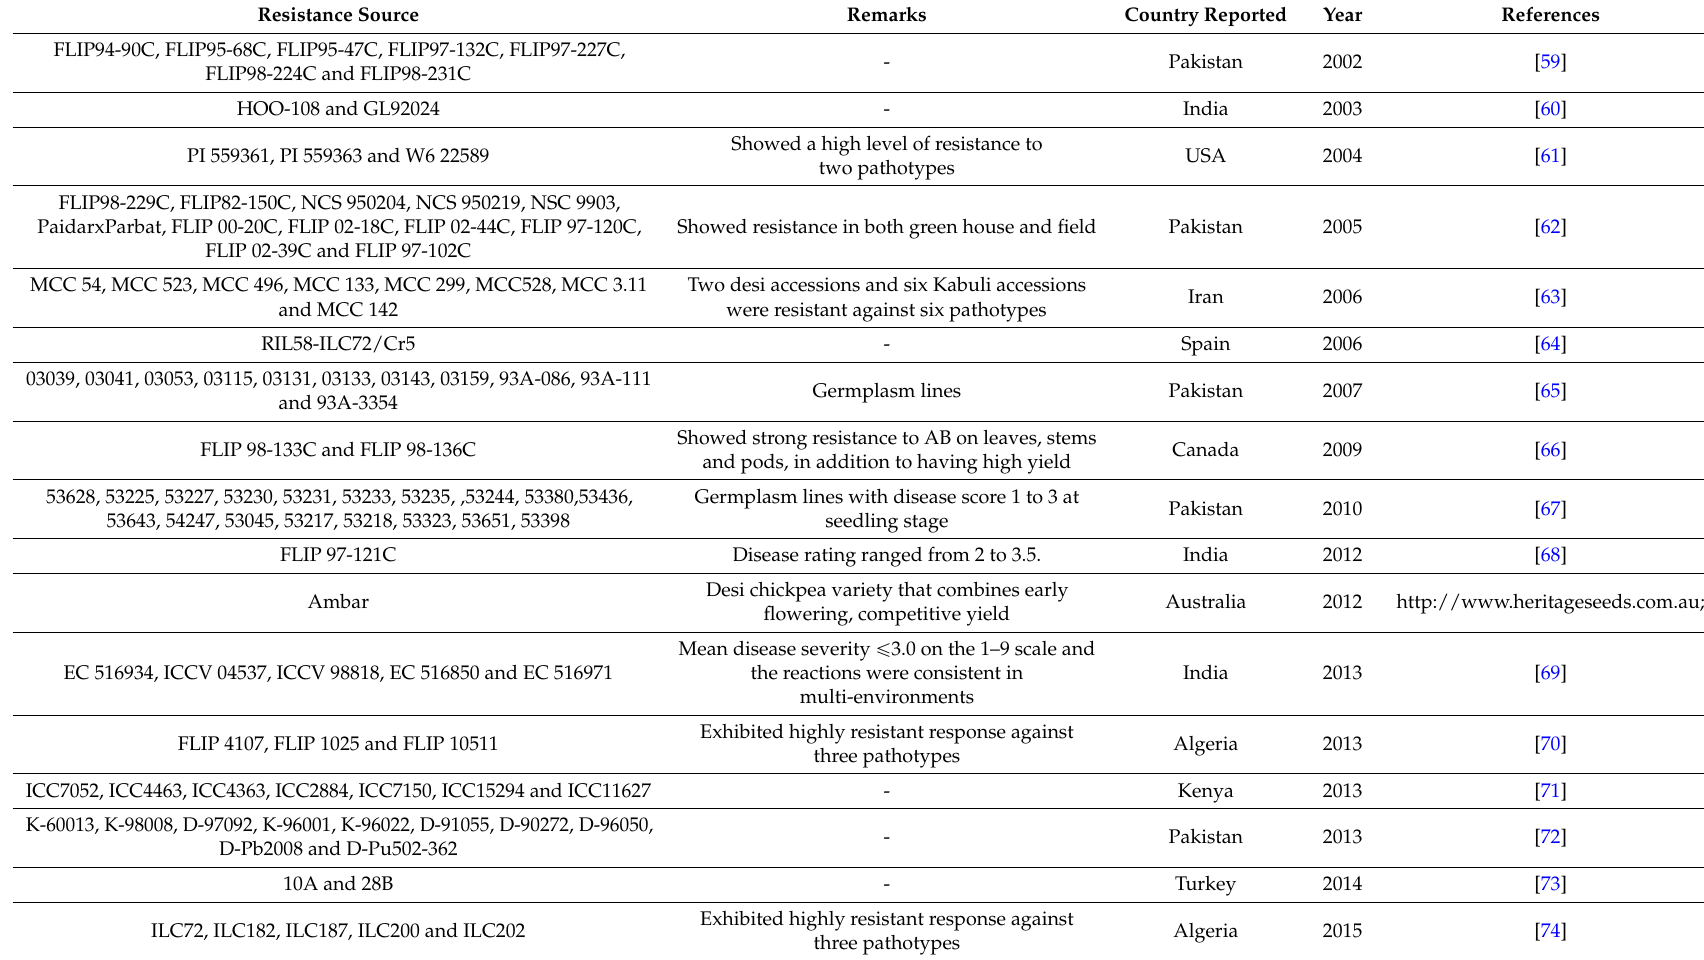
Table 2. An updated list of Ascochyta blight-resistant chickpea sources